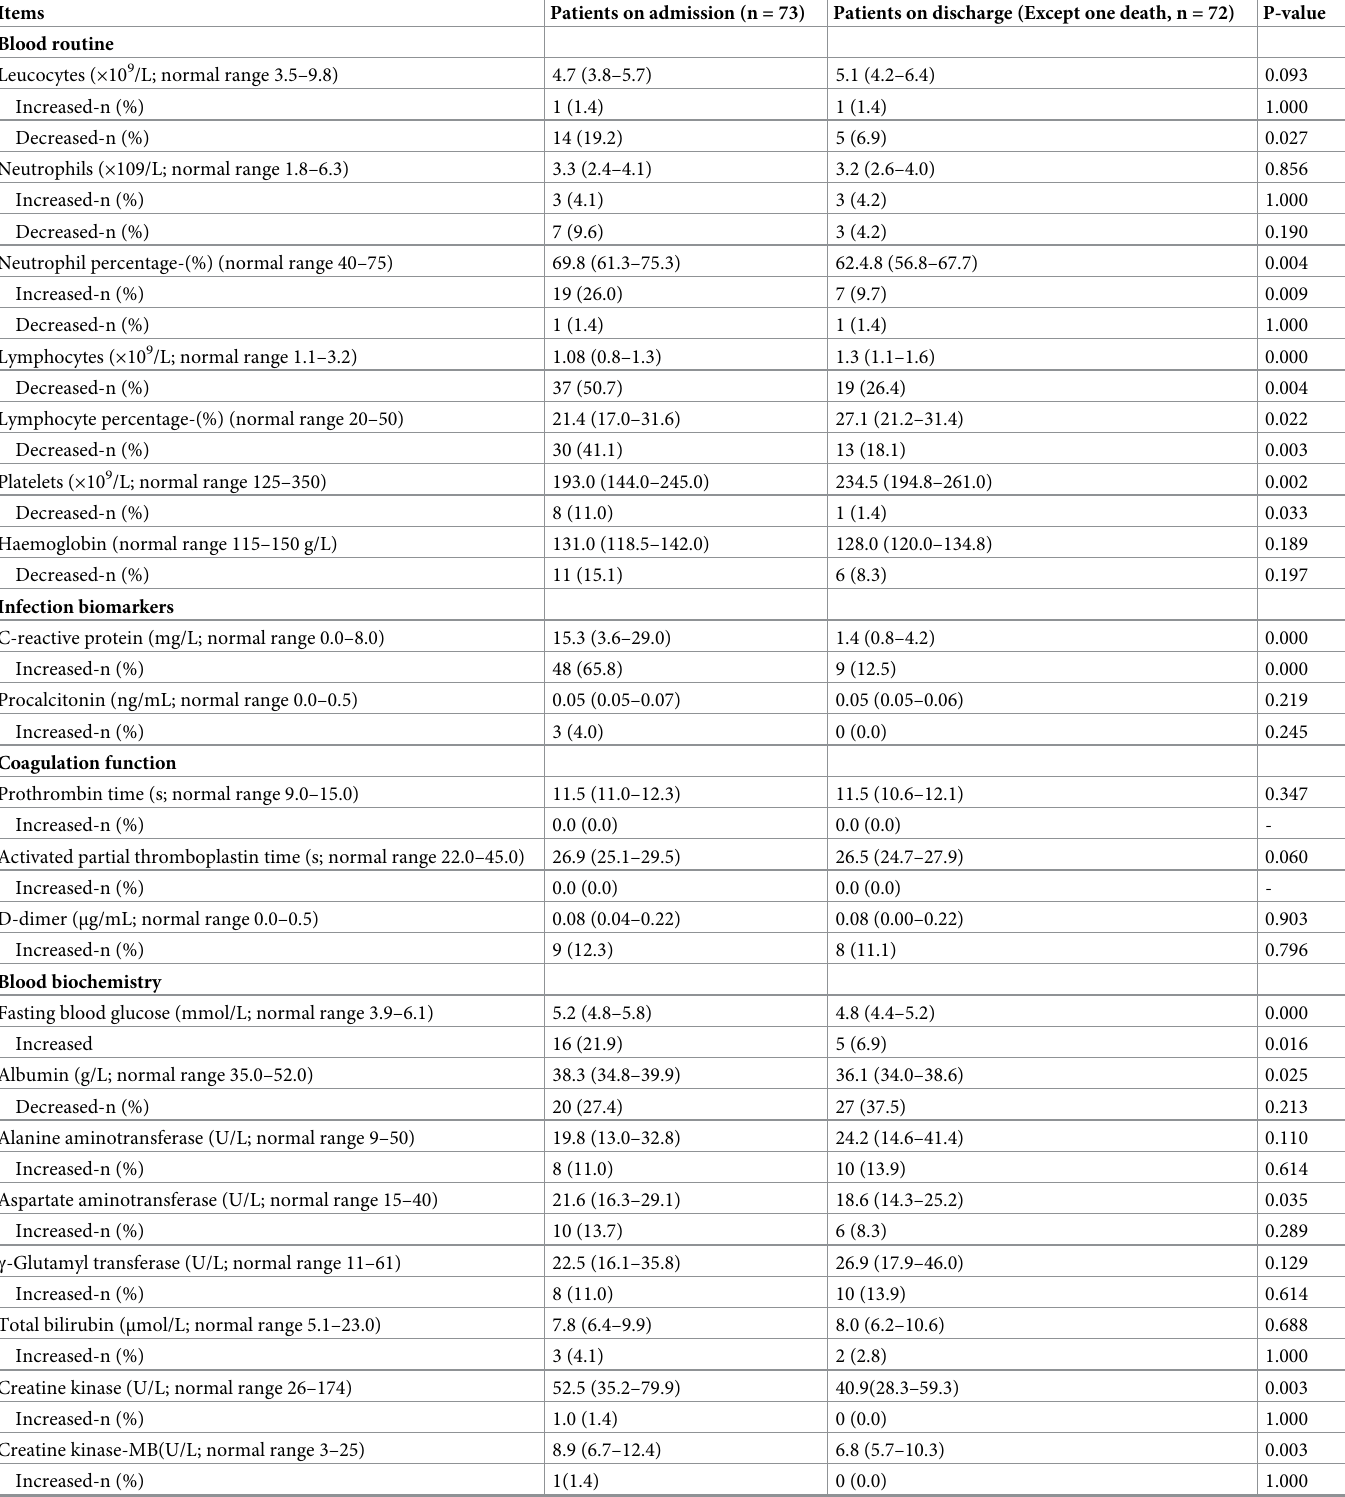
Table 2. Laboratory characteristics of 73 moderate patients with